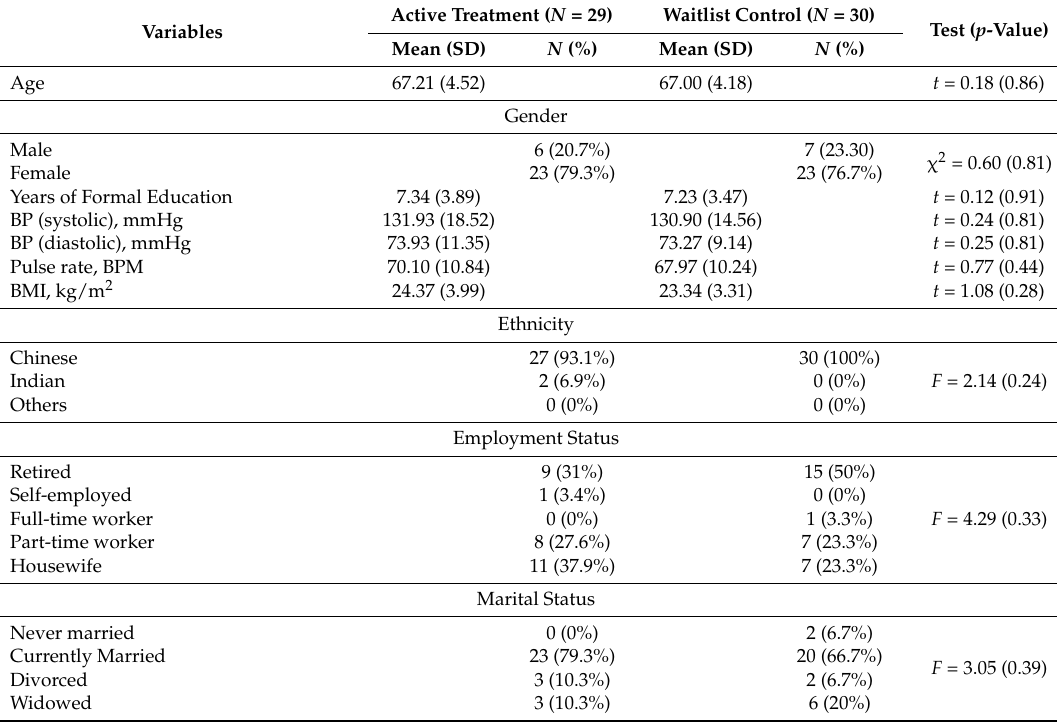
Table 2. Comparison of baseline characteristics between participants in the horticultural therapy and waitlist control